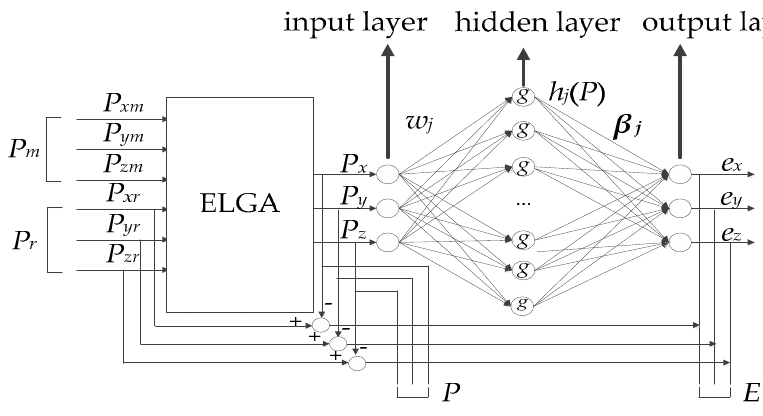
Figure 3. Extreme learning machine (ELM) calibration model.